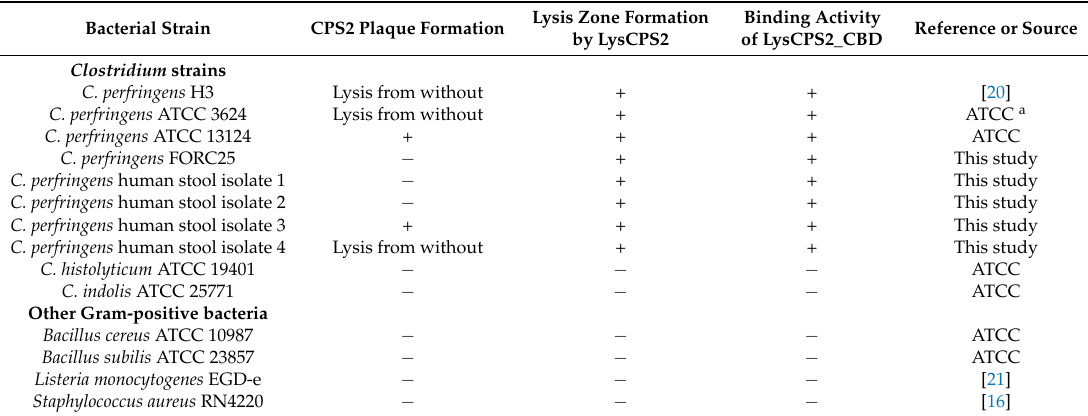
Table 1. Antimicrobial spectra of the CPS2 and LysCPS2, and binding spectrum of LysCPS2_CBD. Bacterial